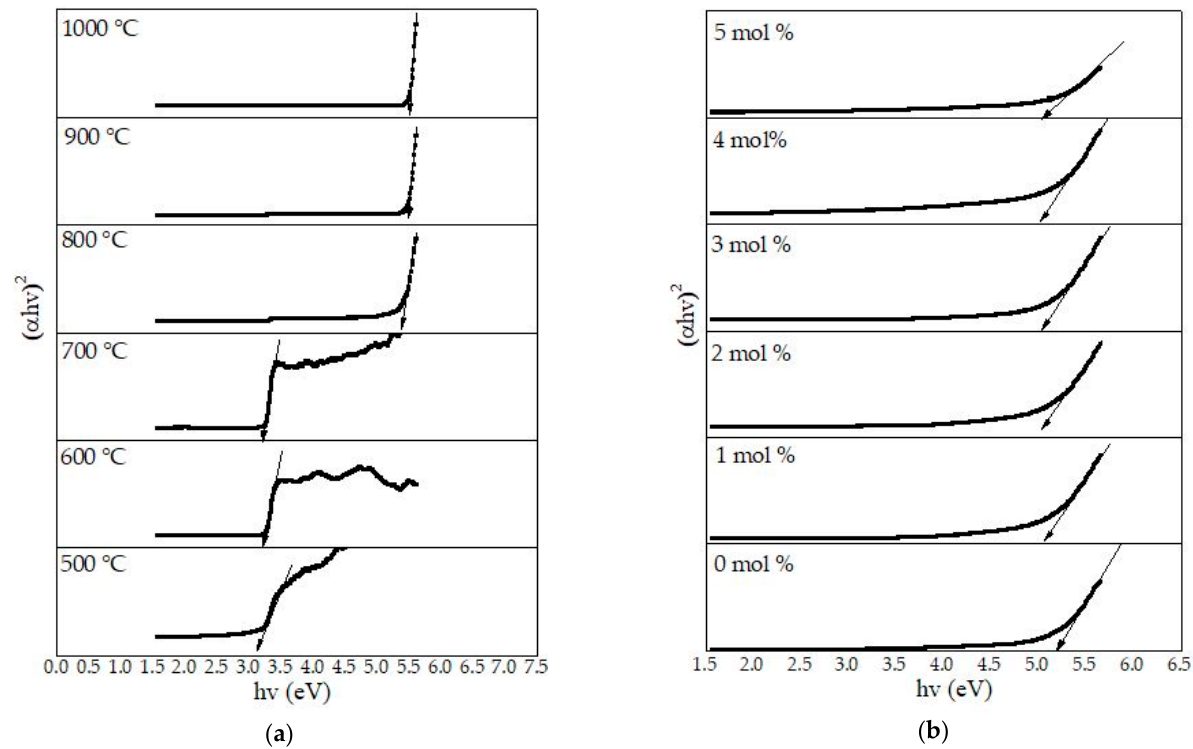
Figure 15. Plot of ( ∝ hv ) 2 versus hv for ( a ) willemite NPs calcined at different temperatures, and ( b ) willemite doped with different Ce 3+ concentrations calcined at 900 °C. Table 4. Willemite NPs optical band gap at various calcination temperatures.